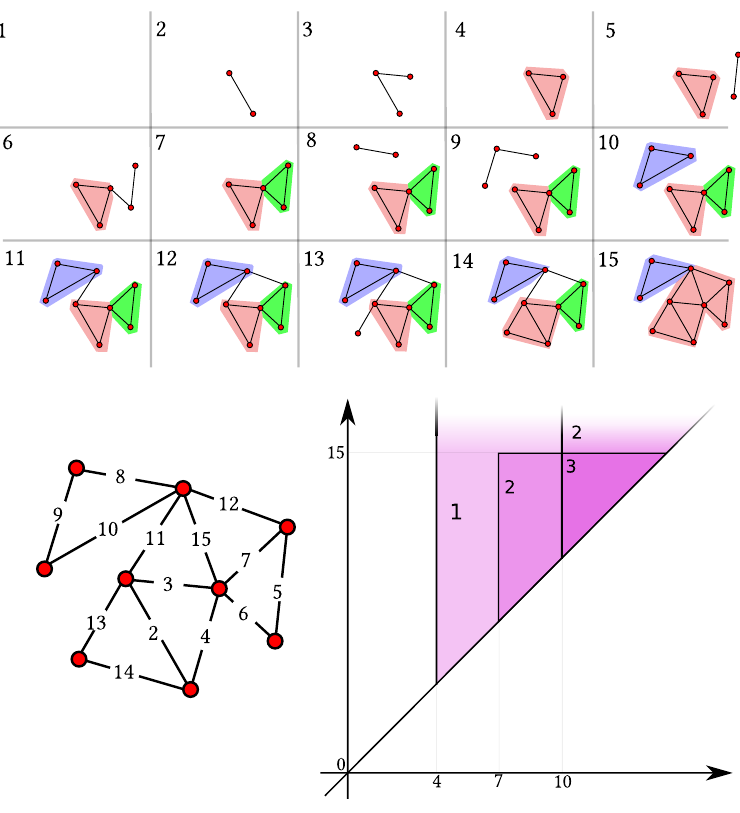
Figure 4. The weighted graph of Figure 1 (left), the corresponding filtration (above) and its 3-clique community number